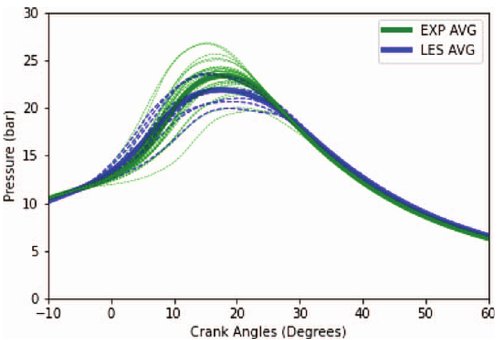
Fig. 15. g -equation model and LESI ignition model: in-cylinder AHRR for LES (blue) and experiments (green). Individual cycles are denoted by the dashed lines and the ensemble average is denoted by bold